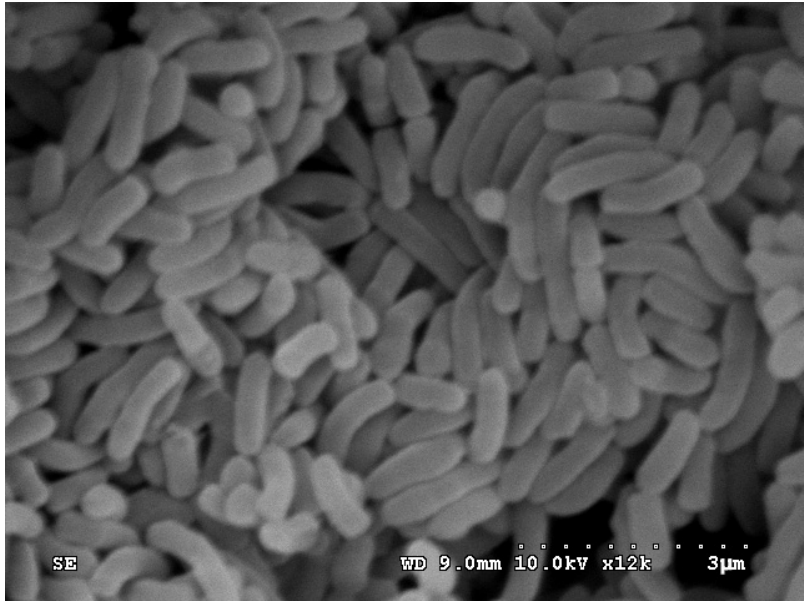
Figure 2. Phylogenetic tree derived from the 16S rRNA gene sequence of strain TJ and sequences from related species. Distances were calculated using the neighbor-joining method. Numbers at branch points are bootstrap values based on 1000